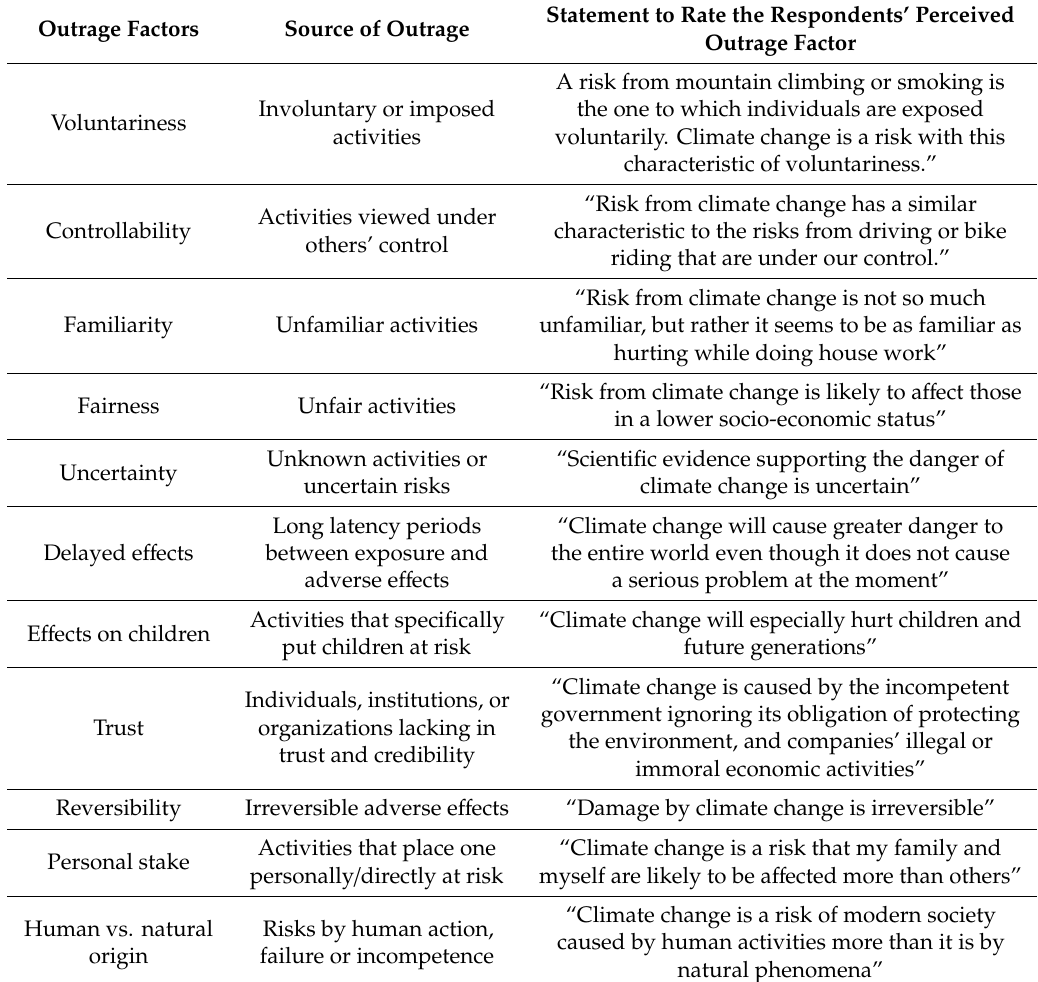
Table 2. The statements utilized to measure perceived outrage factors and source of outrage from which the statements were